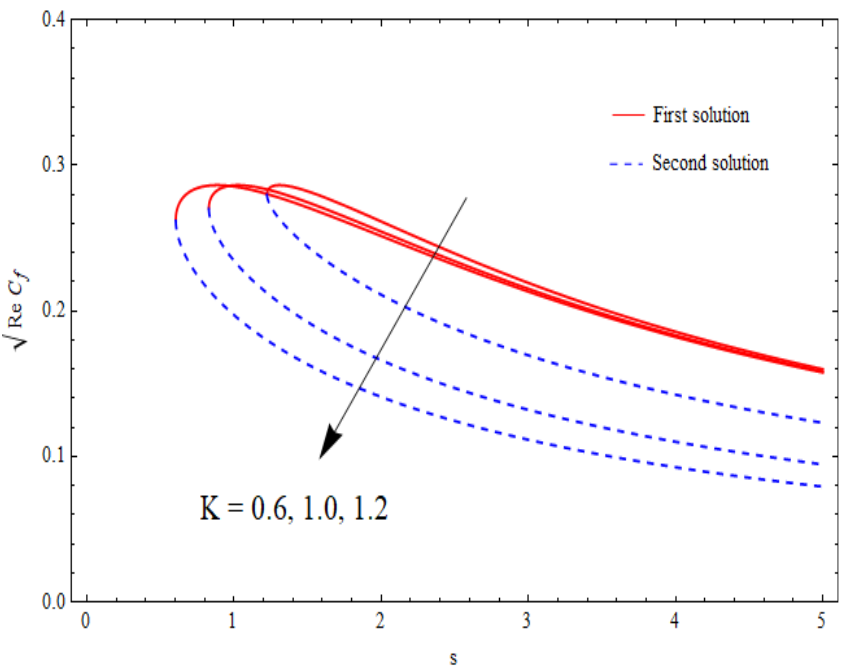
√ Re C f against s for different ϕ 1 when λ = − 1.5, Re C against s for different 1  when f  =−===−=